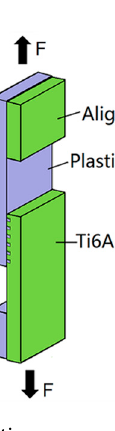
Figure 2. Schematic representation of tensile shear test.